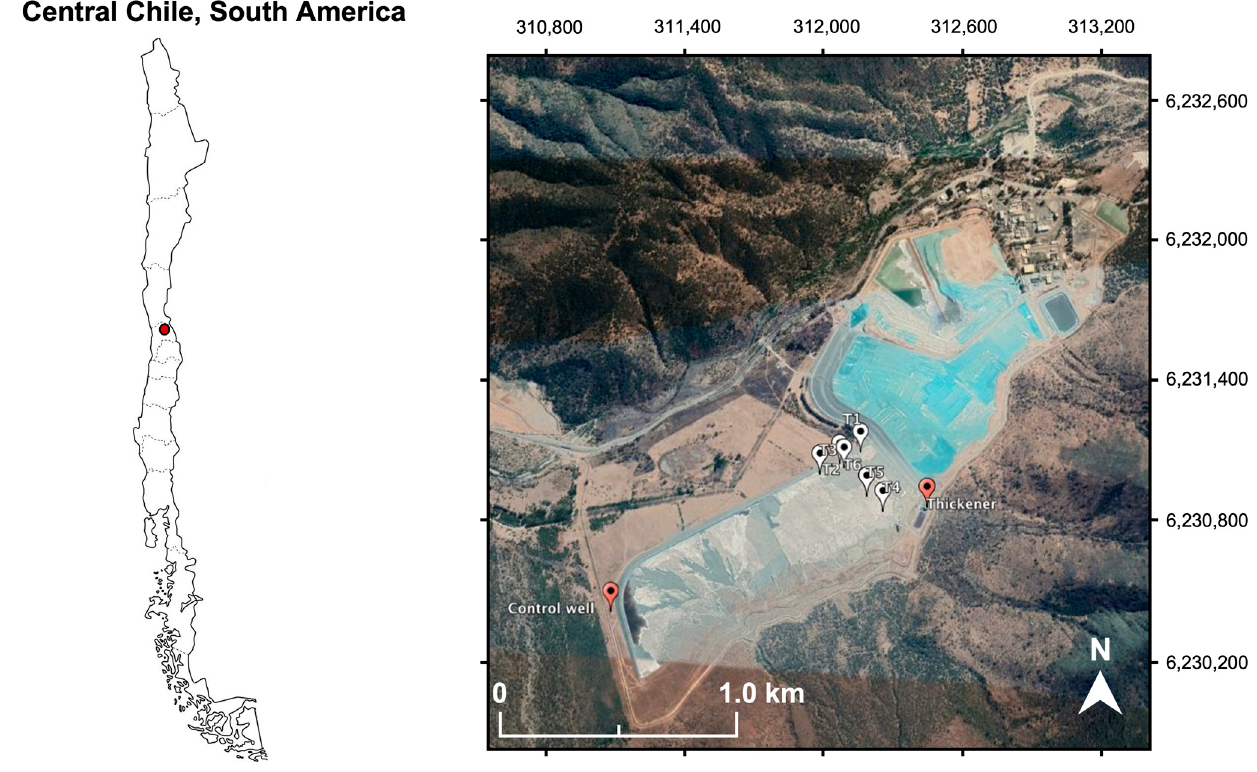
Figure 1. Location of Florida gold-silver Mine, south of Santiago, central Chile. Chemical real-time monitoring was performed in the thickener and in a control well (red marks) located in the mining area. For the analysis of the tailing deposit, tailing samples (T1–T6) were sampled in the points indicated in the figure (white marks).